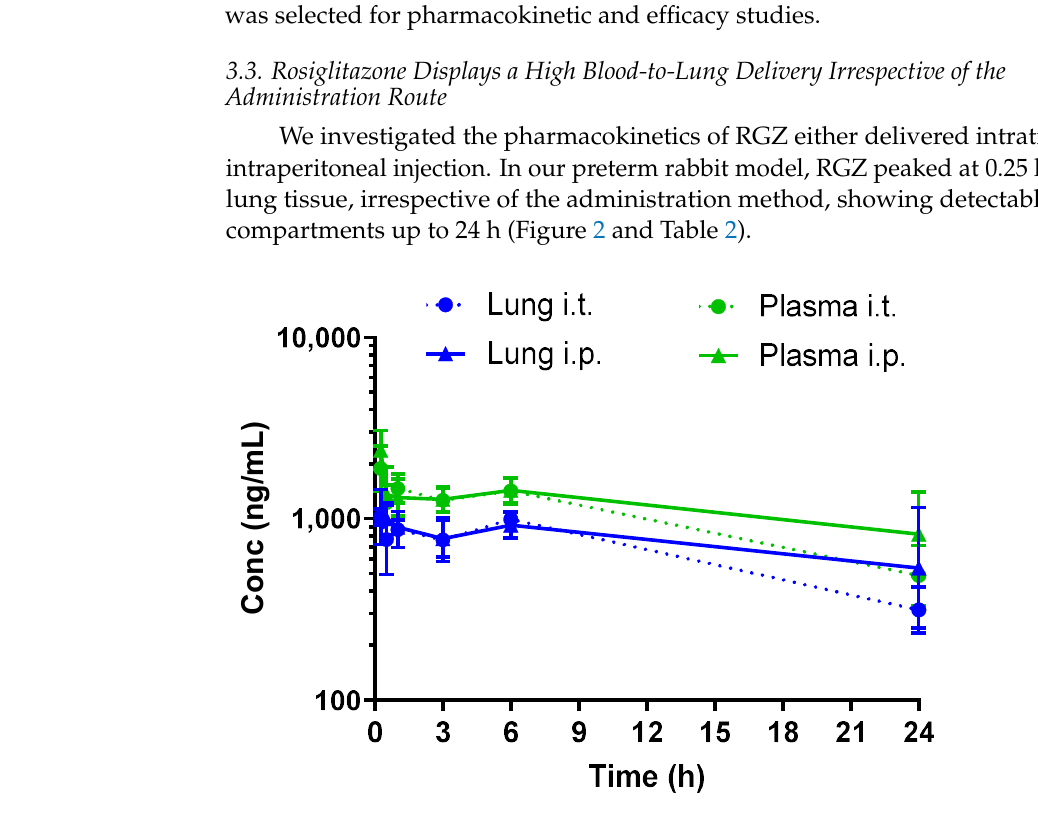
Figure 2. Pharmacokinetic profiles of rosiglitazone (1 mg/kg) following intratracheal (i.t.) or intraperitoneal (i.p.) administration to preterm rabbits. Table 2. Pharmacokinetic parameters after either intratracheal or intraperitoneal administration of rosiglitazone (1 mg/kg) to premature rabbit pups.